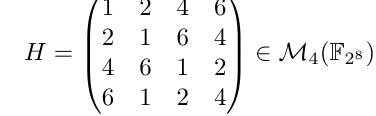
Algorithm 5 applied on the AES MixColumns outputted the matrices of Table 11. The lines are represented as hexadecimal numbers with the first column element being the least significant bit (i.e. the rightmost